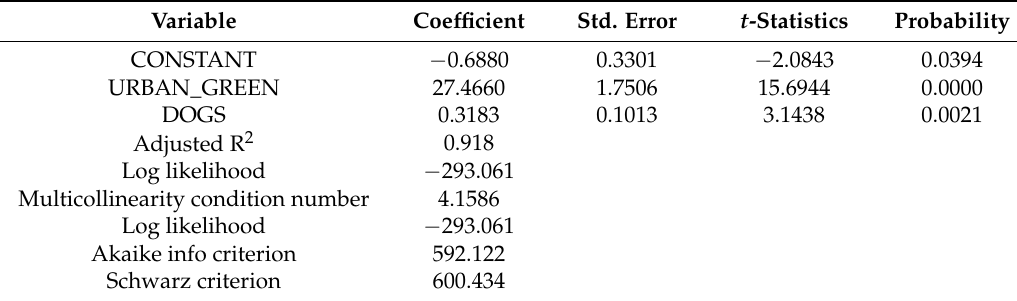
Table 4. Ordinary Least Squares